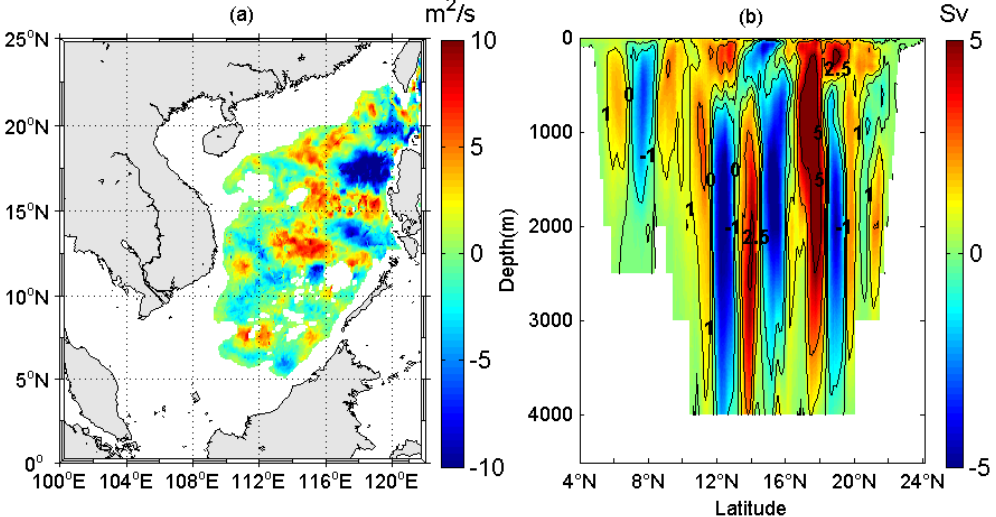
Figure 5. The snapshot of (a) the integrated meridional velocity field from the bottom to 1000m and (b) the filtered SCSMOC signal at 24:00GMT in January